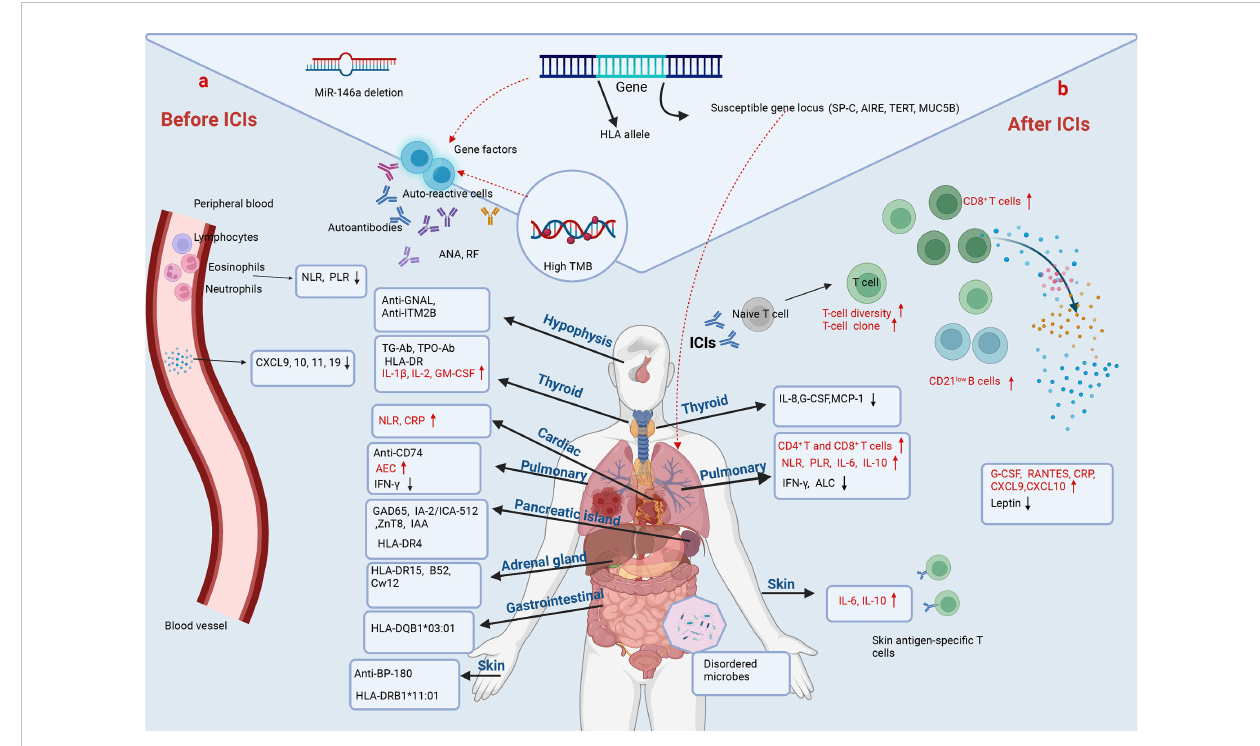
FIGURE 2 Predictive biomarkers of irAEs in NSCLC. (A) Before ICIs. The baseline cytokines, chemokines, peripheral-blood cell counts, and pre-existing antibodies and genetic alterations are associated with irAEs in NSCLC. Lower baseline levels of NLR, PLR, CXCL9, CXCL10, CXCL11 and CXCL19 correlate with irAEs. MiR-146a deletion even predicts the occurrence of severe irAEs. However, the baseline NLR and CRP are increased in NSCLC with immune-related cardiotoxicities. The pre-existing anti-GNAL and anti-ITM2B in plasma predict immune-related hypophysitis. ICI-related thyroid dysfunction is associated with pre-existing TG-Ab, TPO-Ab, HLA-DR, and higher baseline value of IL-1 b , IL-2 and GM-CSF. Anti-CD274, a higher baseline level of AEC and lower baseline IFN- g and ALC are associated with CIP. HLA alleles and autoantibodies as indicated are related to immune- related diabetes, colitis, adrenal and skin adverse events. Age, BMI and past medical history have also been shown to be strongly associated with irAEs. (B) After ICIs. An increased diversi fi cation of peripheral T-cell repertoire, early expansion of CD8 + T-cell clones ( ≥ 55), and increased circulating CD21 low B cells characterized by higher PD-L1 expression and greater clonality after immunotherapy are associated with irAEs. Higher post-treatment levels of serum G-CSF, RANTES, CRP, CXCL9 and CXCL10, and lower post-treatment leptin correlate with irAEs. Changes of cytokines during ICI treatment predict organ-speci fi c adverse events. Decreased IL-8, G-CSF and MCP-1 predict immune-related thyroid dysfunction. Increased IL-6 and IL-10, and decreased IFN- g predict CIP. Increased IL-6 and IL-8, and the presence of skin antigen-speci fi c T cells in blood after ICIs predict skin toxicities. In addition, disturbances in gut microbes are associated with gastrointestinal